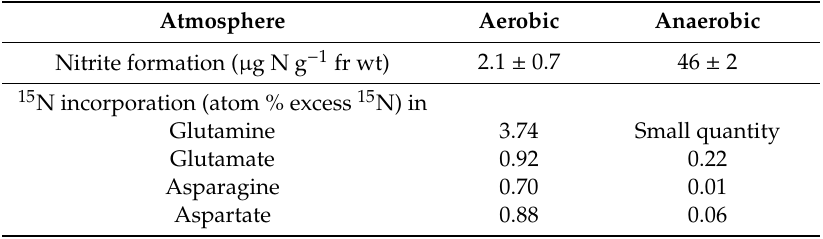
Table 2. Nitrite formation and 15 N incorporation into amino acids in the wheat leaf segments treated